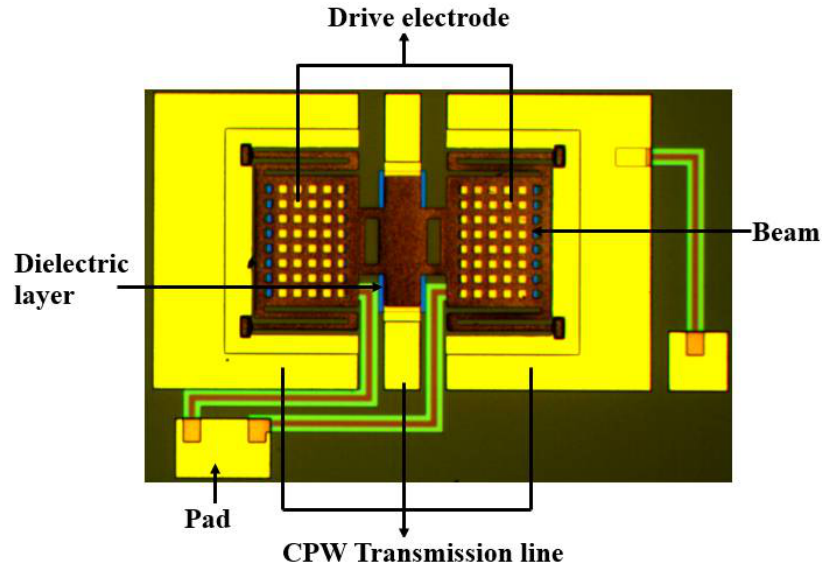
Figure 8. Micrograph of the fabricated MEMS switch.